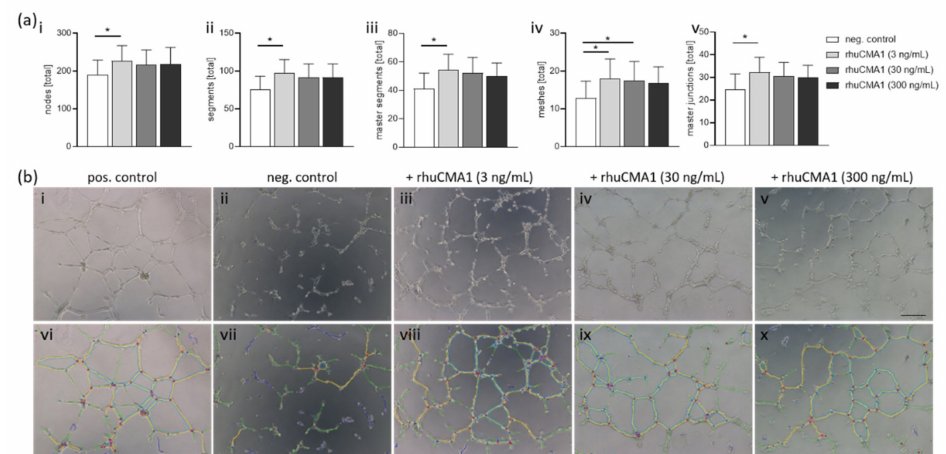
Figure 7. rhuCMA1 induces HUVEC endothelial-tube formation. Tube formation of HUVECs incubated with rhuCMA1 (3 ng/mL, 30 ng/mL, 300 ng/mL) was evaluated after 4 h for number of nodes ( a ( i )), segments ( a ( ii )), master segments ( a ( iii )), meshes ( a ( iv )), and master junctions ( a ( v )). Representative cell-culture images ( b ( i – v )) and images analyzed with the Angiogenesis Analyzer tool of Image J ( b ( vi – x )) are shown (scale bar 200 µ m). Results are presented as mean with SEM. Statistical analysis was performed using the Friedman test (* p < 0.05). HUVEC: Human umbilical- vein endothelial cells; rhuCMA1: recombinant human